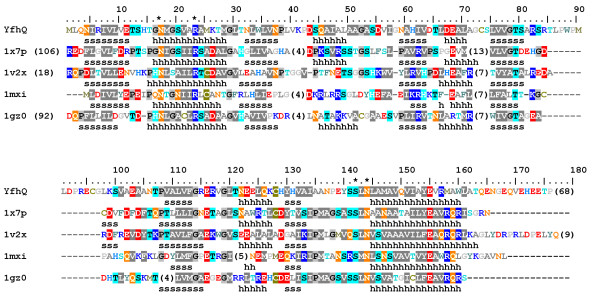
Fold recognition alignment between YfhQ and the experimentally solved structures of SPOUT MTases. The sequence of YfhQ has been aligned to the structures of RlmB from Escherichia coli (1gz0.pdb), AvirB from Streptomyces viridochromogenes (1x7p.pdb), TrmH from Thermus thermophilus (1v2x.pdb), and YibK from Haemophilus influenzae (1mxi.pdb), using the GeneSilico meta server [24]. Amino acid residues predicted to be involved in cofactor binding and in the methyl transfer reaction are indicated by asterisks ("*").